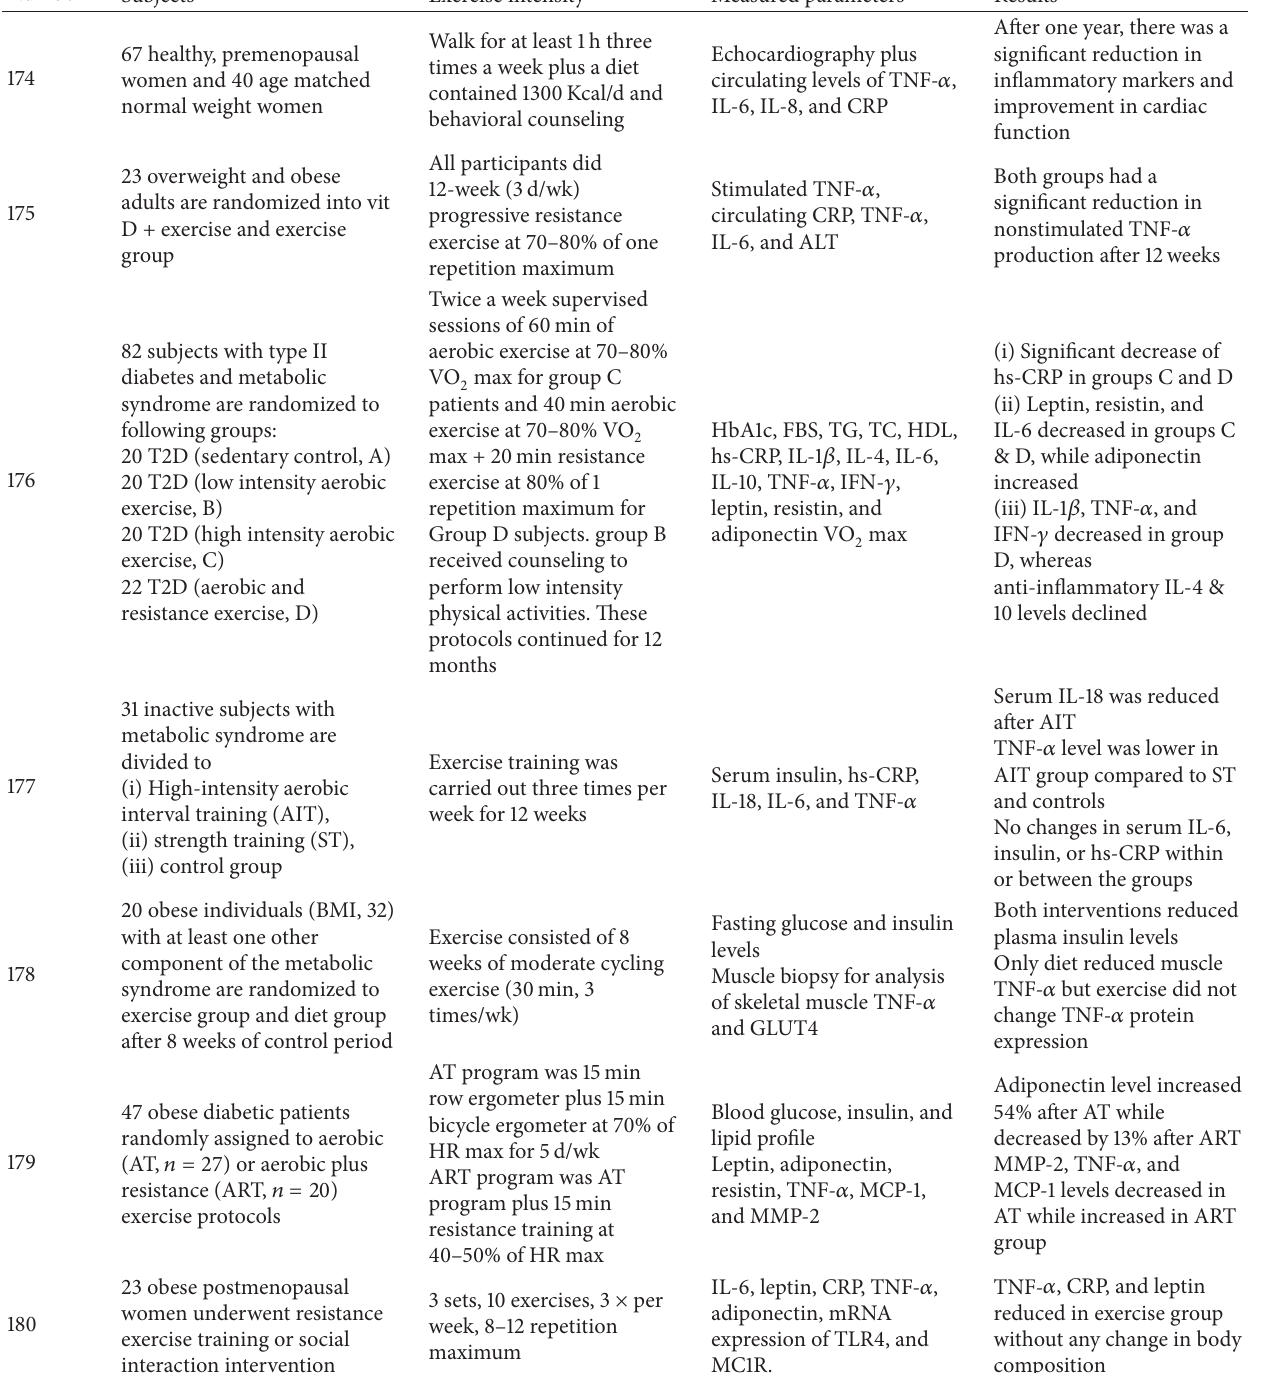
Table 4: Summary of selected clinical trials in which TNF- 𝛼 level has been measured as a clinical outcome before and after exercise.